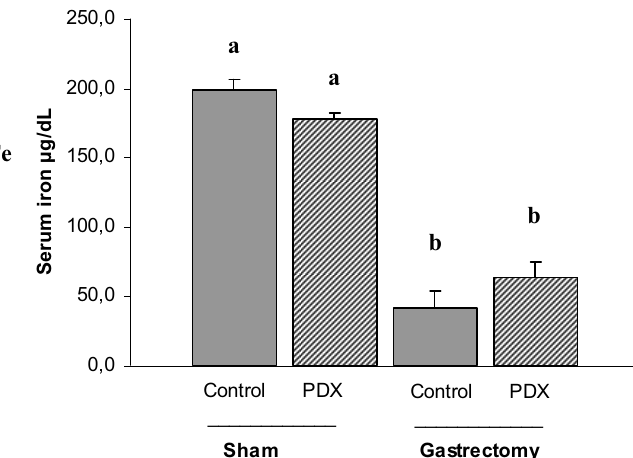
FIGURE 3 - Serum iron in sham operated or rats with gastrectomy fed diets with polydextrose (PDX) or without polydextrose (control). Each values represents the means ± SEM (Sham/Control: n=10; Sham/PDX: n=10; Gastrectomy/Control: n=9; Gastrectomy/PDX: n=9). Two ANOVA main effects (treatment and diet) and interactions (treatment x diet) were significant. Diet (control or PDX) treatment (with or without gastrec- tomy). Bars not sharing a common superscript are significantly differ- ent, p<0.05 (Duncan‘s multiple range test) concentration of iron in feces in the sham-operated rats an ctomy receiving polydextrose enriched-diet was lower (P < 0 ared to the control diet (Figure 4).